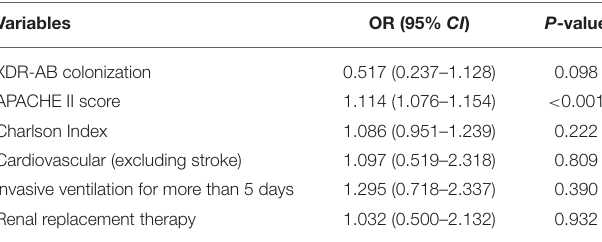
TABLE 3 | Multivariate Logistic regression of Factors Associated with 28-day